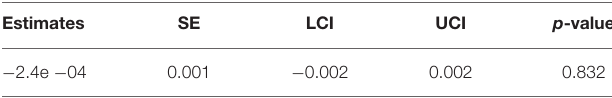
TABLE 3 | MR-Egger intercept test results of the association between HI and falls. Estimates SE LCI